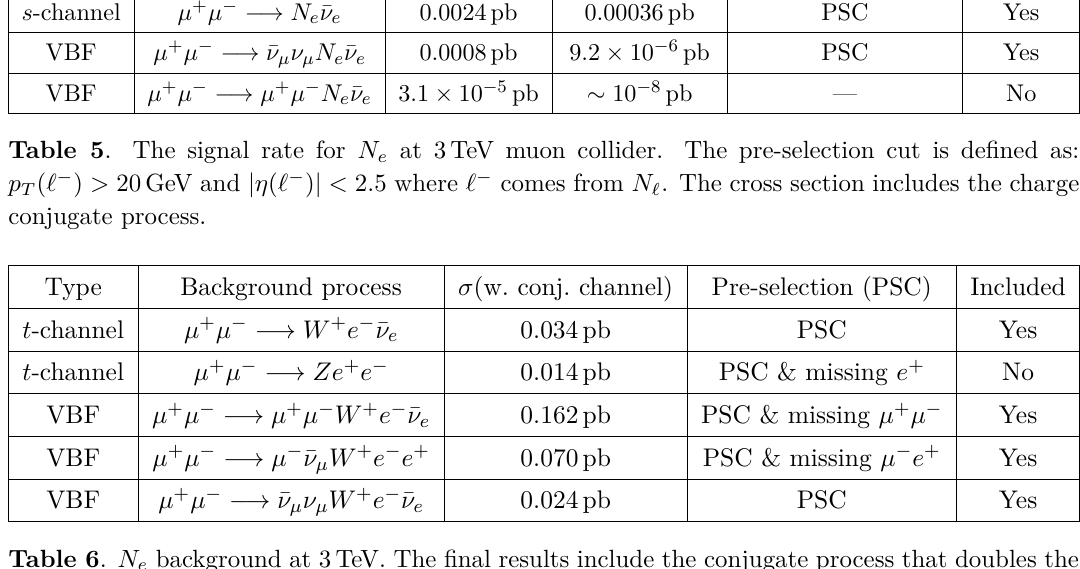
Table 6 . N e background at 3 TeV. The final results include the conjugate process that doubles the cross-section reported